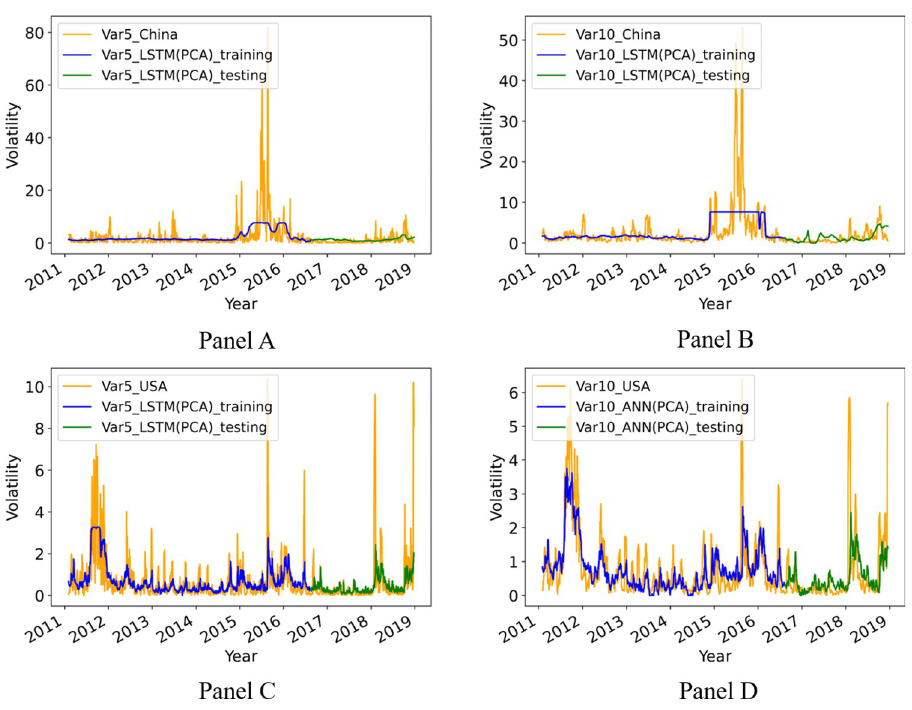
Fig 5. The realized and predicted volatilities of CSI300 and S&P500 index